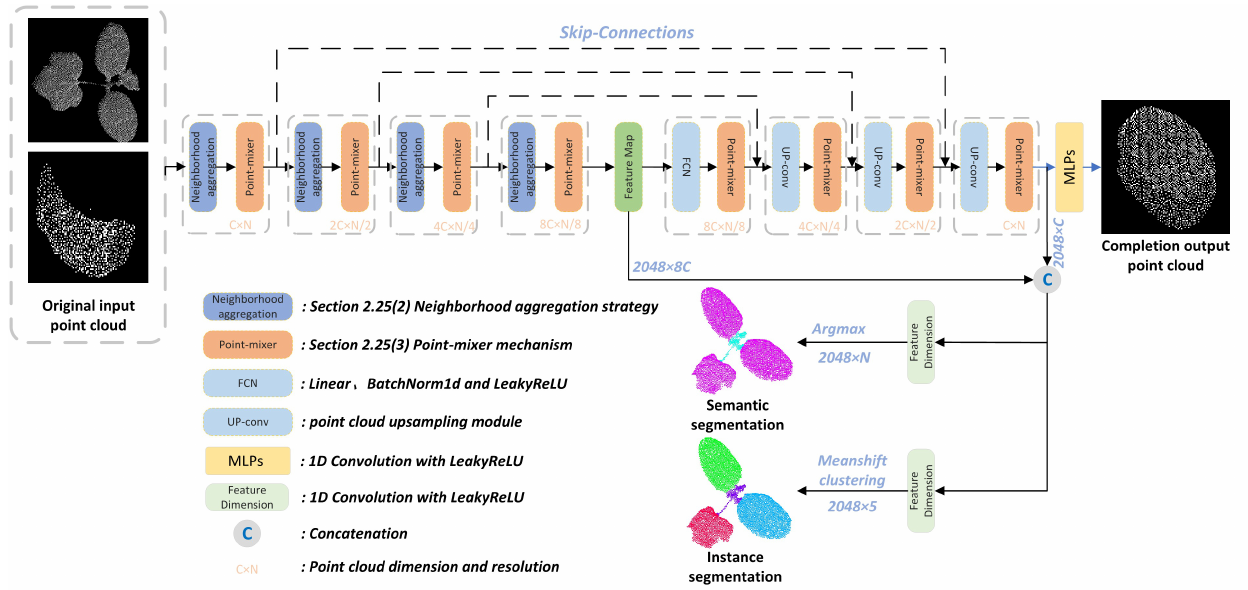
Figure 2. The complete structure of MIX-Net. The left part of the figure is the encoder, and the right part is the decoder. The neighborhood aggregation module is the neighborhood aggregation strategy proposed in Section 2.2.6. The point-mixer is the multi-level feature fusion module proposed in Section 2.2.7. The UP-conv module is the PointAtrousGraph, the point cloud up-sampling module proposed in the